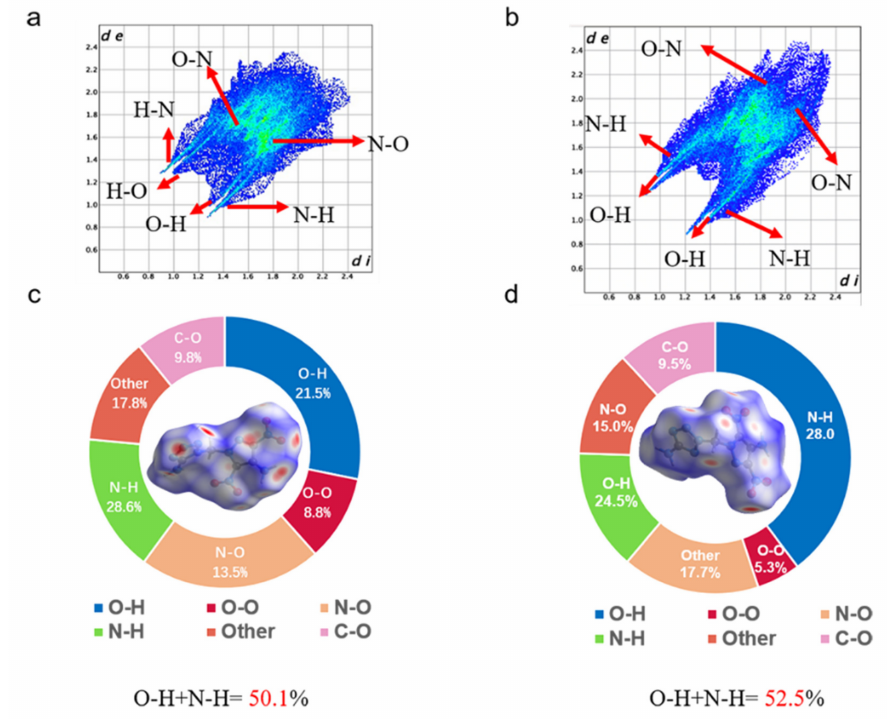
Figure 4. The 2D fingerprint plots of DMPT-1 ( a ) and DMPT-2 ( b ); Hirshfeld surface analyses for DMPT-1 ( c ) and DMPT-2 ( d